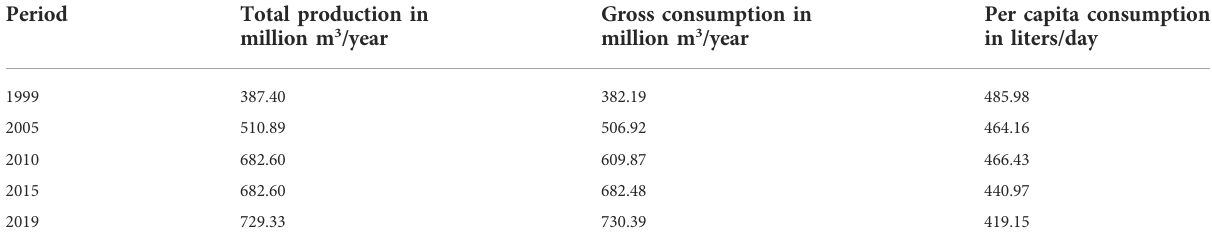
TABLE 6 Production and consumption of fresh water in